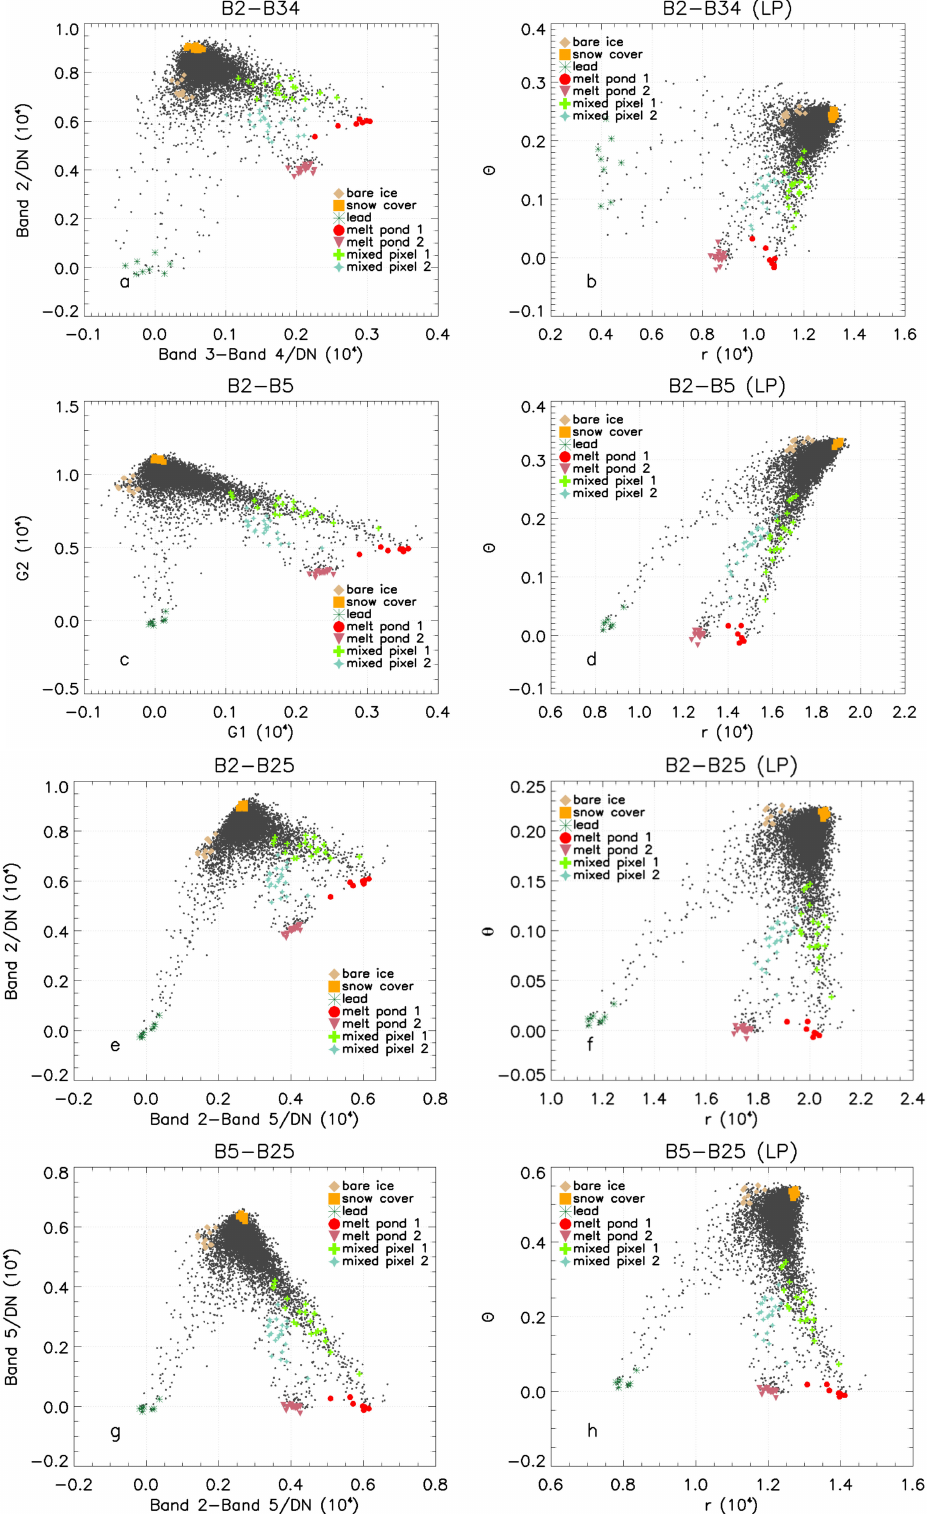
Figure 5. The scatterplots of the four band combinations. ( a ) B2–B34; ( c ) B2–B5 after PCA transformation; ( e ) B2–B25; ( g ) B5–B25; ( b ), ( d ), ( f ) and ( h ) are ( a ), ( c ), ( e ), and ( g ), respectively, after LinearPolar